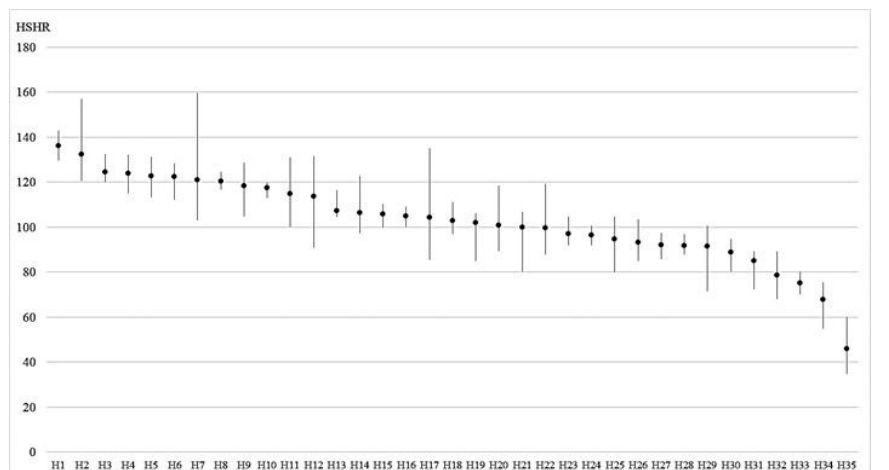
SD = standard deviation. HSHR = hospital standardized home-transition ratio.